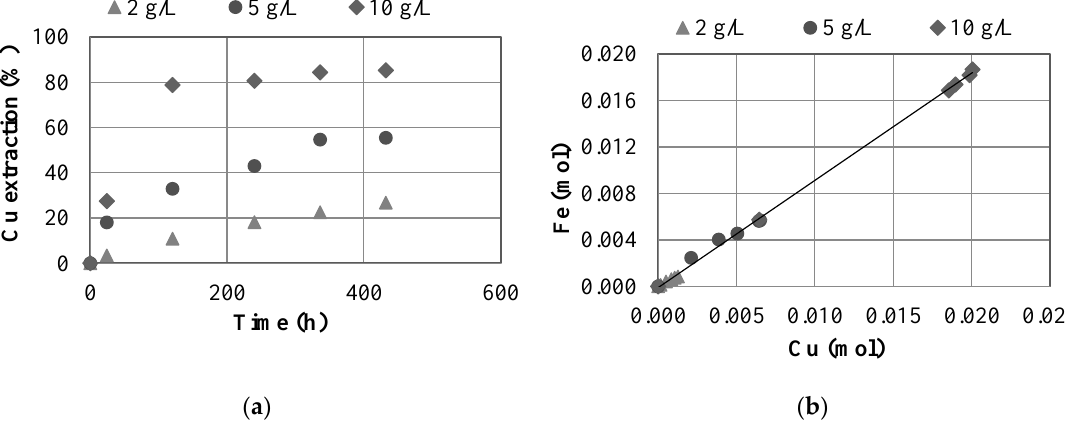
Figure 2. ( a ) Copper extraction (%) versus time (h) at different solid/liquid ratio: 2, 5 and 10 g/L. ( b ) Cu/Fe molar ratio at solid/liquid ratio: 2, 5 and 10 g/L. Experimental conditions: [NaNO 3 ] = 0.7 M, [H 2 SO 4 ] = 0.7 M, seawater as dissolvent, −150 + 75 µm, 45 °C, 350 rpm, sample A.